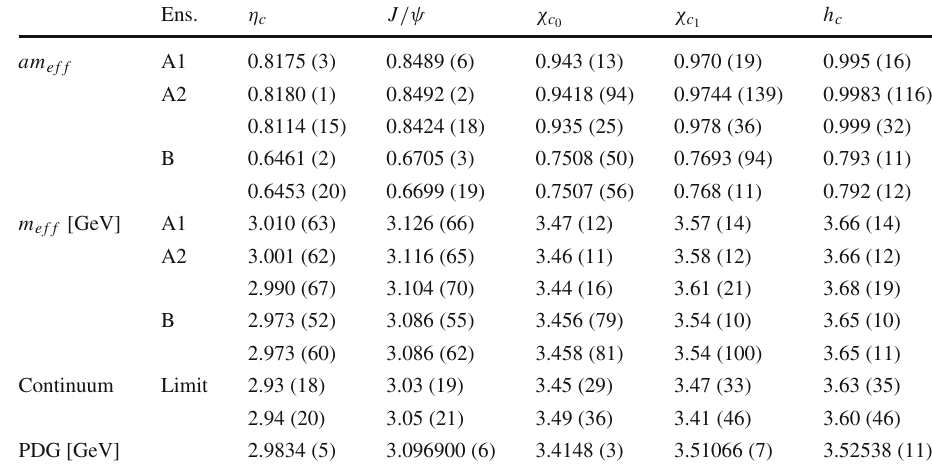
Table 6 Effective lattice and physical masses of charmonium states η c , J /ψ , χ c , χ c and h c 0 1 together with continuum limit extrapolations and their PDG [14] values, the second row values for ensembles A2 and B are shifted to the correct tuning points φ 4 and φ 5 , for details see Sect. 3.3, Eq. (3.20)